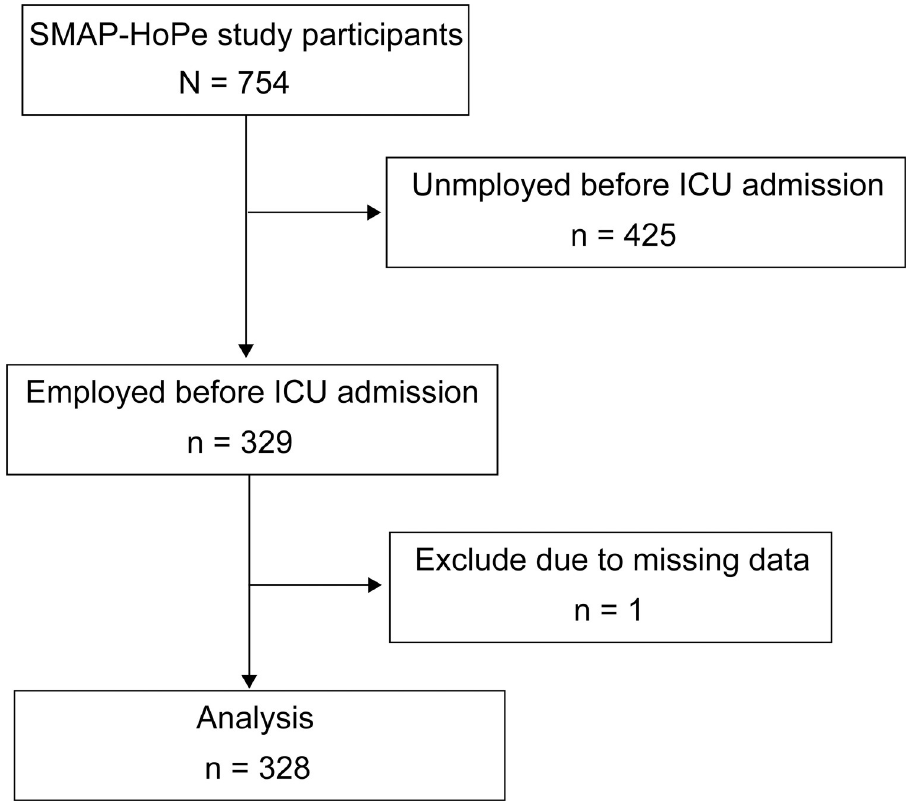
Fig 1. Patient recruitment